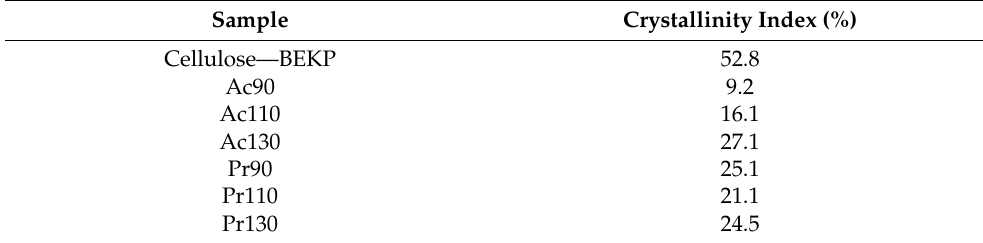
Table 5. Crystallinity index